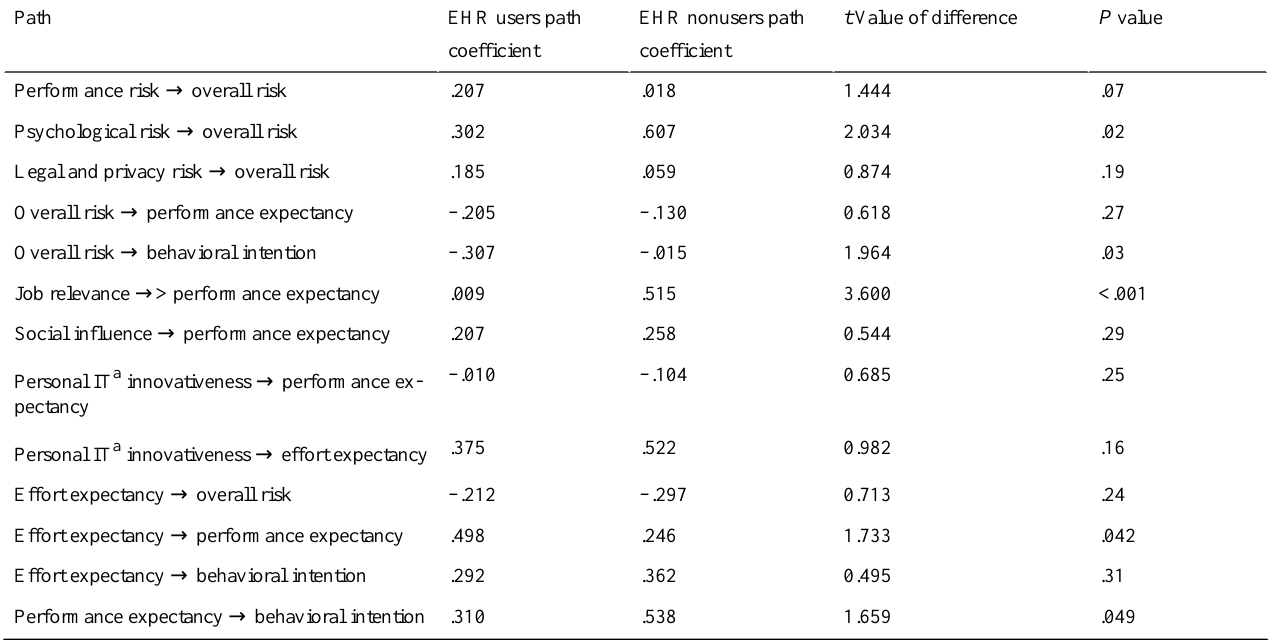
Table 5. Statistical analysis of differences between EHR users and